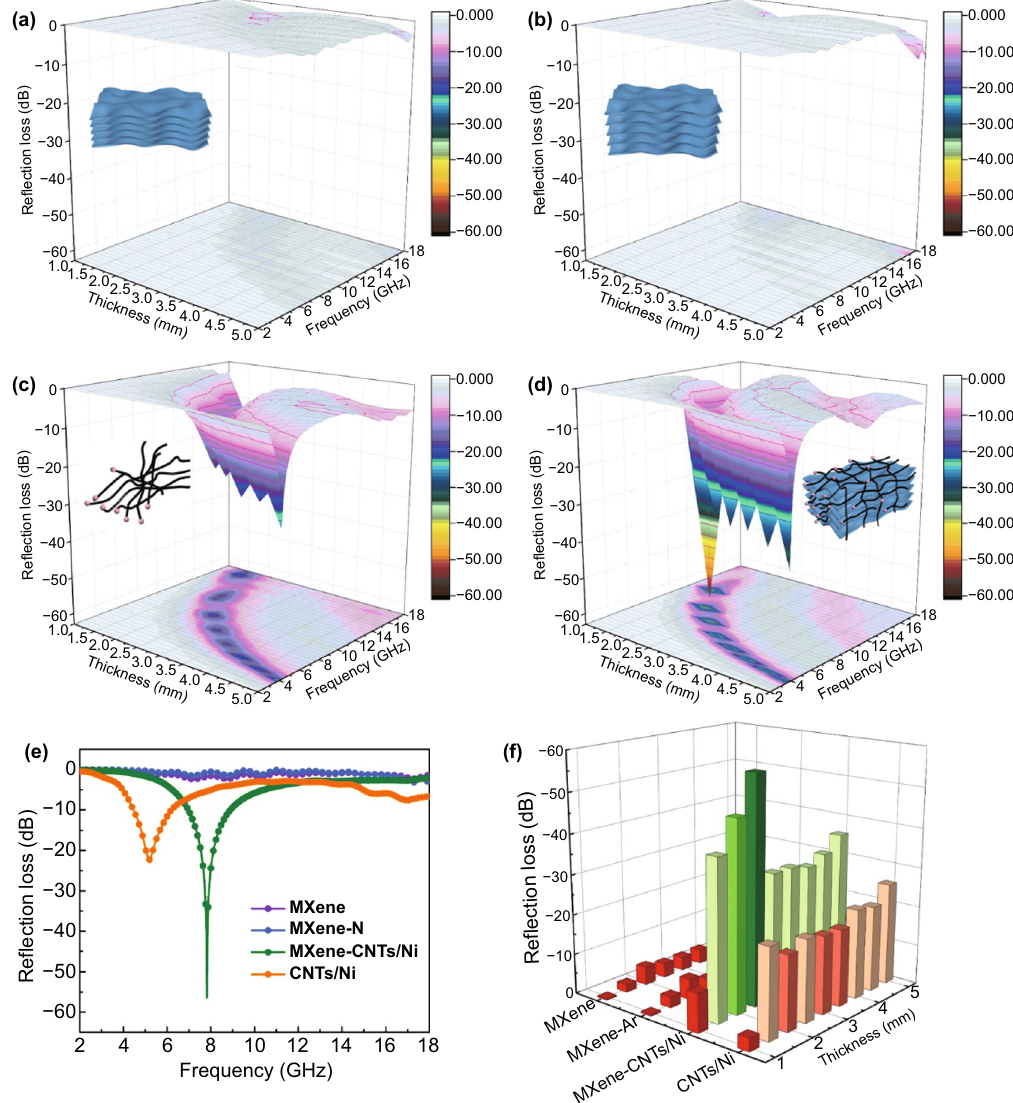
Fig. 5 3D plots for a MXene, b MXene-N, c CNTs/Ni and d MXene-CNTs/Ni composites. e Compared RL curves and f calculated 3D bars for four different